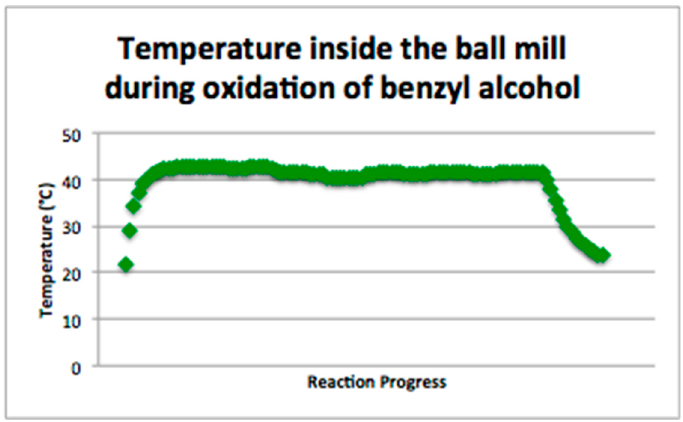
Figure 1. Temperature inside the ball mill during oxidation of benzyl alcohol.